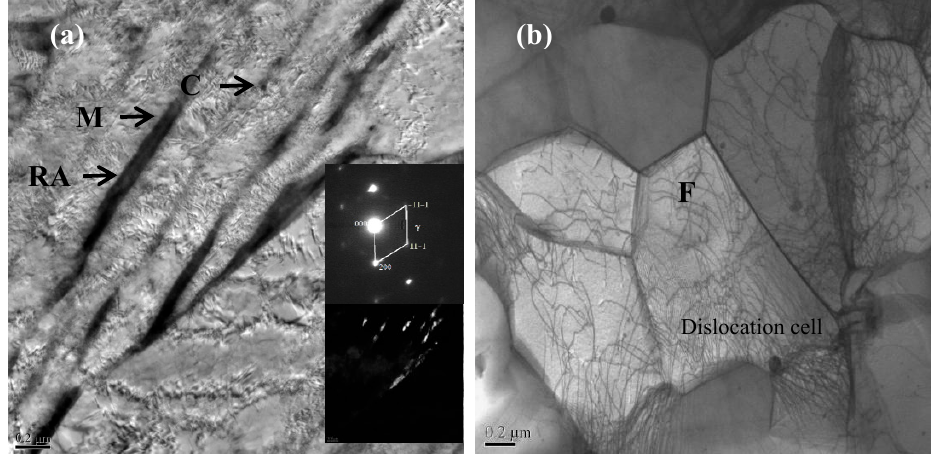
Figure 5. TEM image of the test steel with different microstructure feature; ( a ) The retained austenite feature when the partitioning time is 10 s with Q&P processing; ( b ) The dislocation cell of ferrite when the relaxtion time is 6 s with DP processing. M is martensite, F is ferrite, RA is retained austenite and C is carbide.